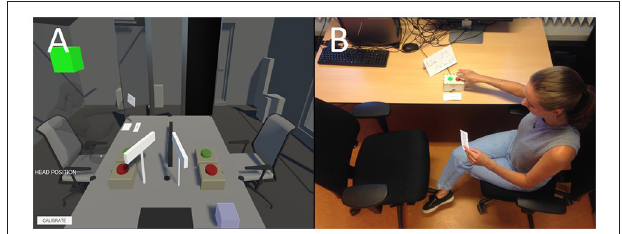
FIGURE 1 | Bird’s-Eye view of the perspective taking exercise in VR and in vivo . Participants VR condition (Panel A ) and in vivo (Panel B ).